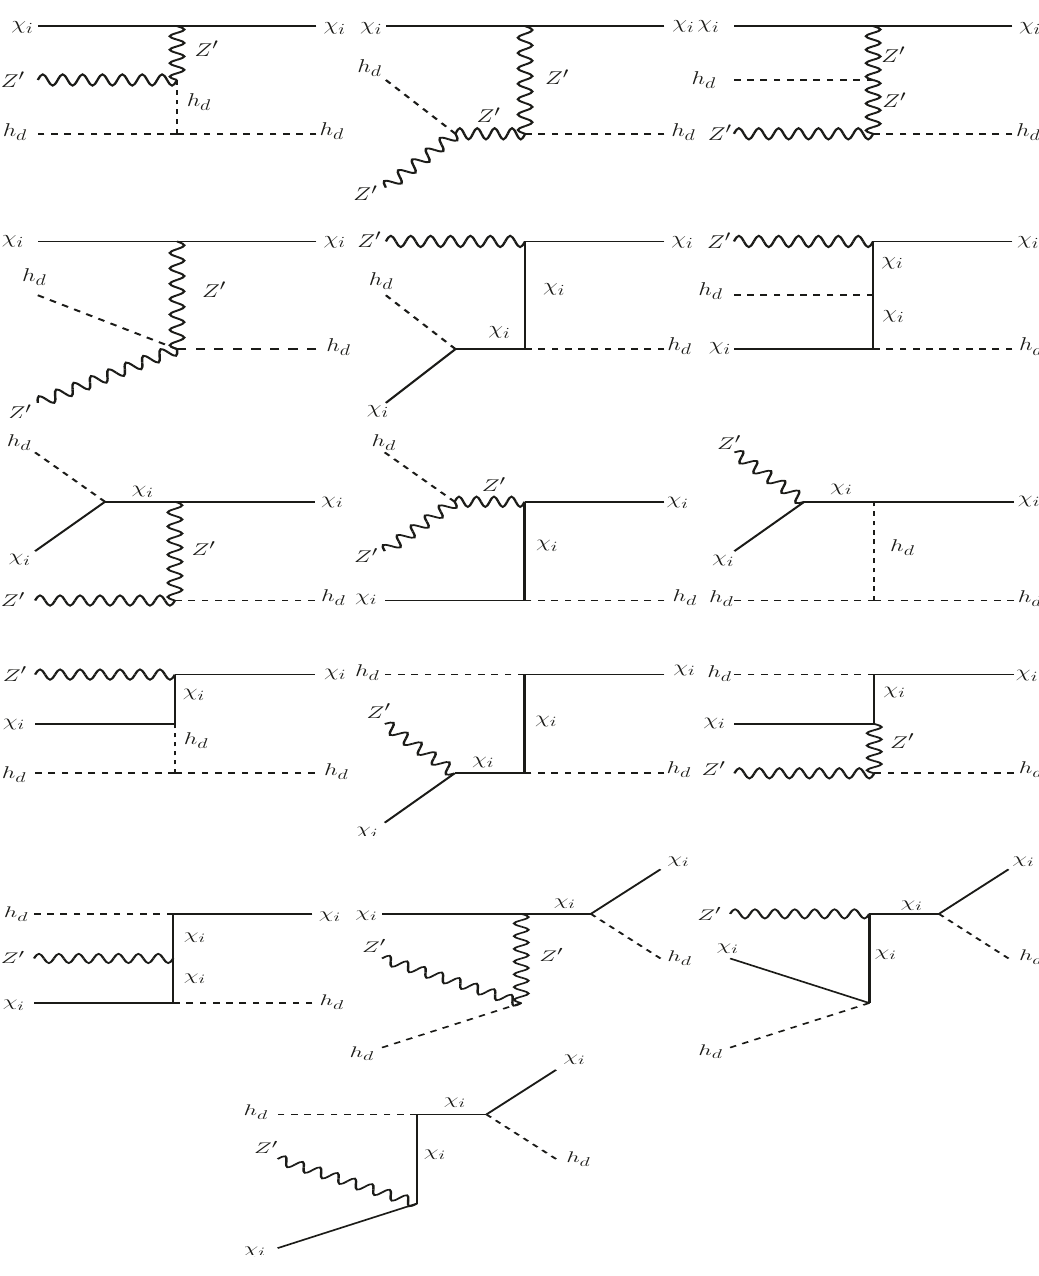
Figure 21 . Feynman diagrams for χ